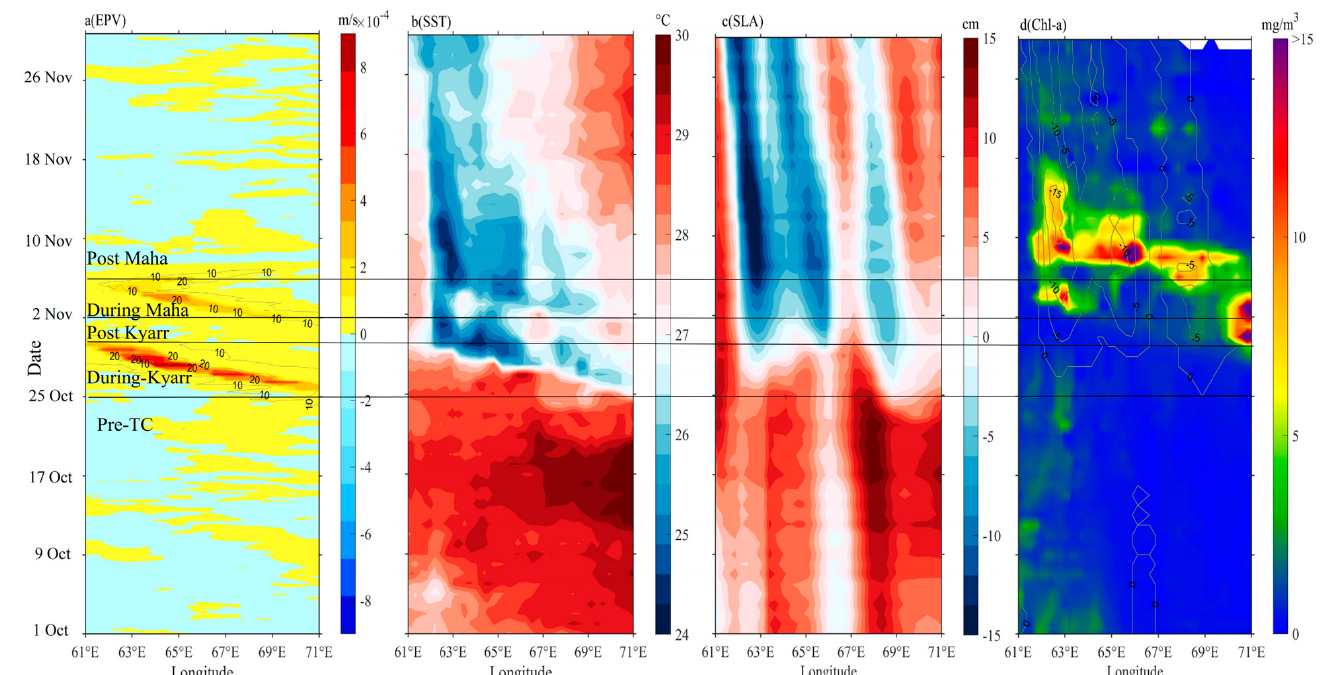
Table 2. Statistical characteristics of the three cold eddies. Figure 4. Daily variations in ( a ) EPV, ( b ) SST, ( c ) SLA, and ( d ) sea surface chl-a concentration along the tracks of the TC Kyarr from 1 October to 30 November. The contour lines represent integer EPV and SLA in ( a ) and ( d ), respectively. Time is divided by four black lines into five periods (Pre-TC: before 25 October; During Kyarr: 26 October to 30 October; Post Kyarr: 1 November to 2 November;